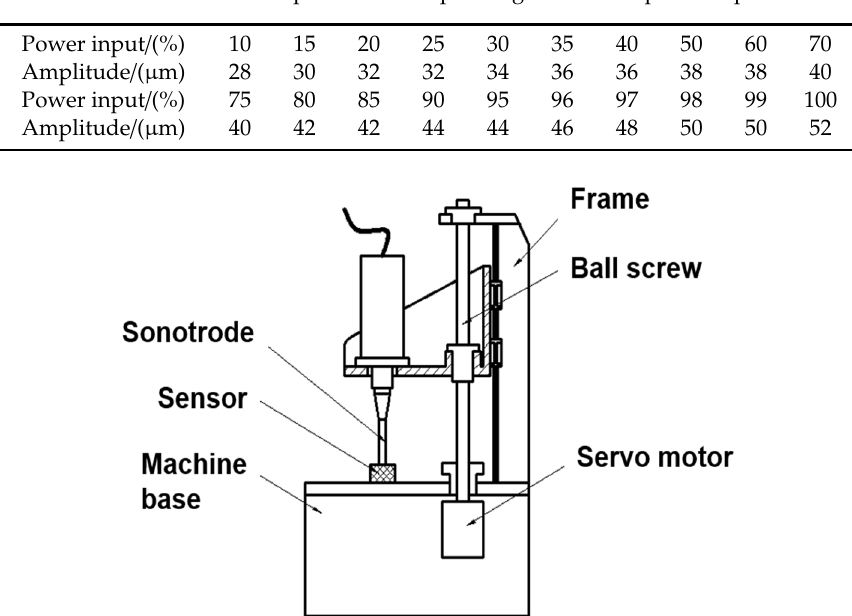
Figure 2. Method for determining plasticizing pressure. Table 3. Ultrasonic amplitudes corresponding to different power inputs.